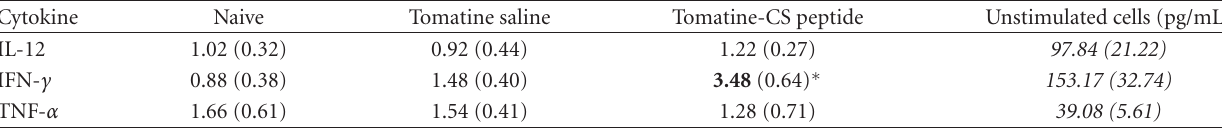
Table 2: Type 1 cytokine production by splenocytes from mice immunized with adjuvant-antigen preparations of tomatine- P . berghei CS peptide or tomatine-saline following ex vivo restimulation with P . berghei CS peptide (25 μ g/mL). Control cytokine production of similarly stimulated splenocytes from naive mice is also shown. Data represent fold increases in secretion of each cytokine over that of splenocytes from identically immunized mice within each group but which were not restimulated ex vivo (absolute levels shown in italics). Data shown represent the mean of four mice, assayed individually in triplicate, from one of four similar experiments. IFN- γ production (shown in bold): ∗ P < . 05 versus tomatine-saline group; P < . 04 versus naive group, determined by the Mann-Whitney U